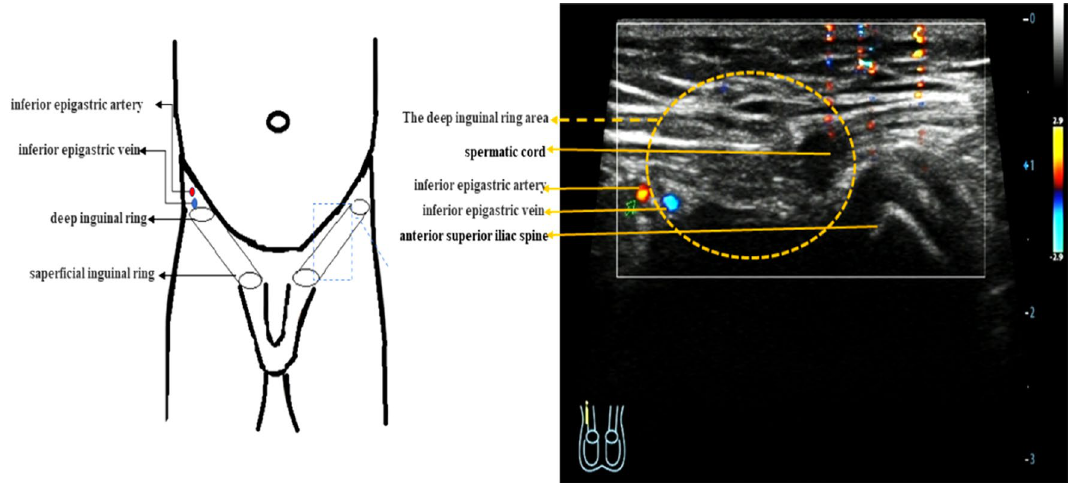
Figure 1. The schematic diagram and ultrasonography image of the inguinal canal in